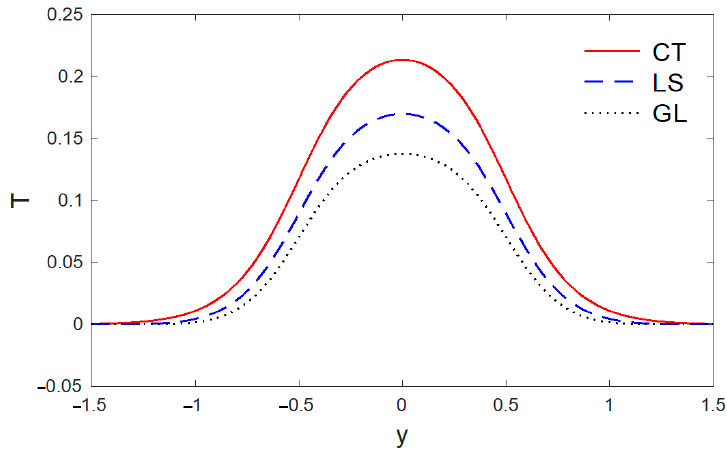
Figure 1. The variation of temperature 𝑇 via 𝑦 , with 𝑥 = 0.5 under the three models.